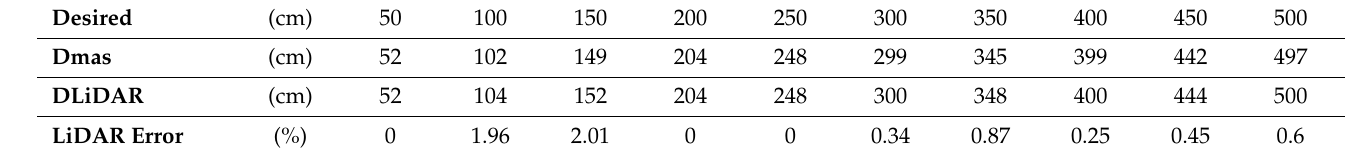
Table 5. Distance measurements with ambient light intensity 265 lux (daylight) and a dark target.